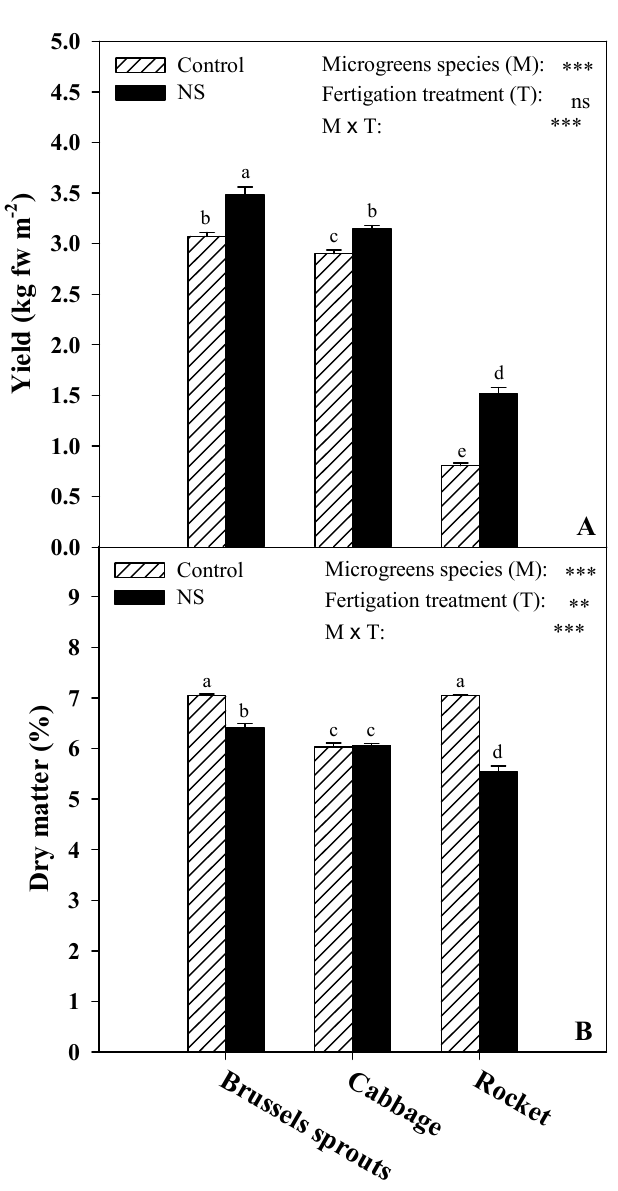
Figure 1. Yield ( A ) and dry matter ( B ) of Brussels sprouts, cabbage and rocket microgreens with respect to nutrient solution treatment. Control: without nutrient supplementation; NS: with nutrient supplementation. All data are expressed as mean ± SE, n = 3. ns, **, *** denote non-significant or significant effects at p ≤ 0.01 and 0.001. Different letters (a–e; A and a–d; B ) indicate significant differences compared by Duncan’s multiple-range test ( p = 0.05).